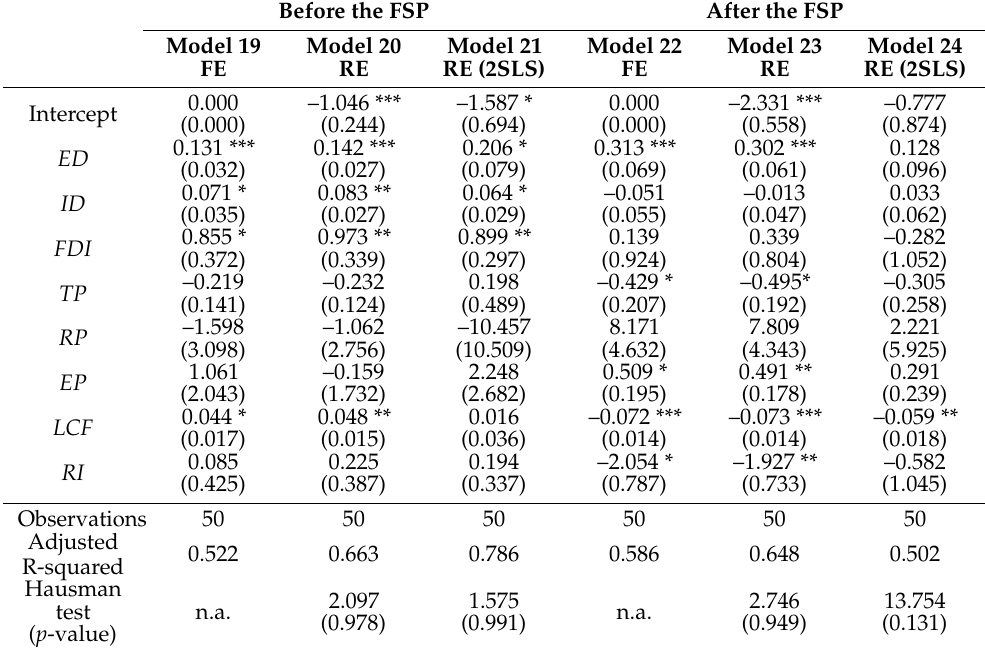
Table 5. Panel data regression results and two-stage least square estimation (2SLS) for Western